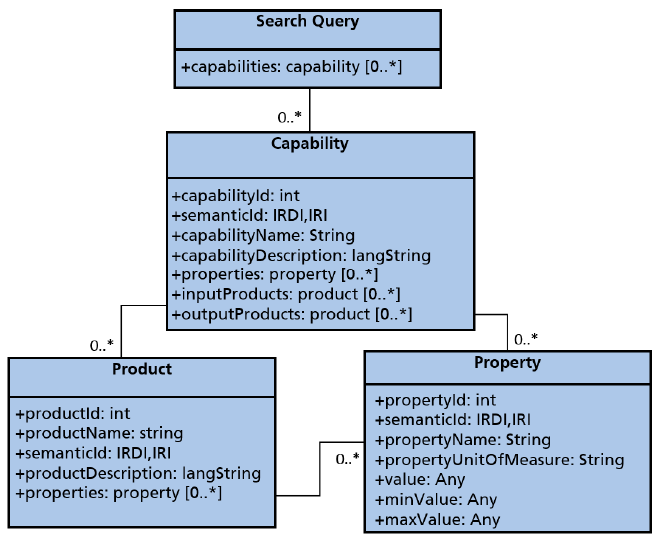
Figure 9. Search query specification.